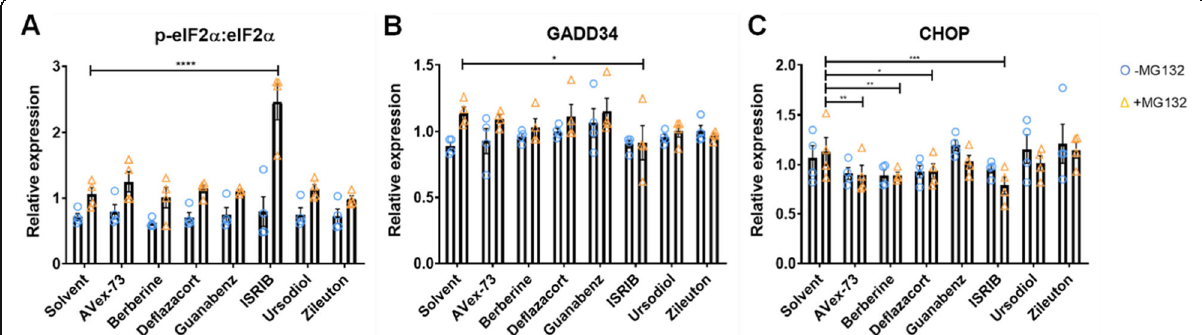
Fig. 3 Effect of candidate drugs on ISR markers in vehicle control (blue circle) or 0.1 μ M MG132-treated (orange triangle) VWMD1 EIF2B5 R113H/A403V patient iPSC-derived astrocytes. Cells were treated with candidate drugs, with or without MG132 for 24 h. Protein expression was measured by western blot and normalised to total protein for the ISR markers: a phosphorylated eIF2 α , normalised to eIF2 α ; b GADD34; c CHOP. Individual data points are shown with mean ± SEM ( n = 4). Significant differences were identified by two-way ANOVA, followed by Holm-Sidak posthoc test